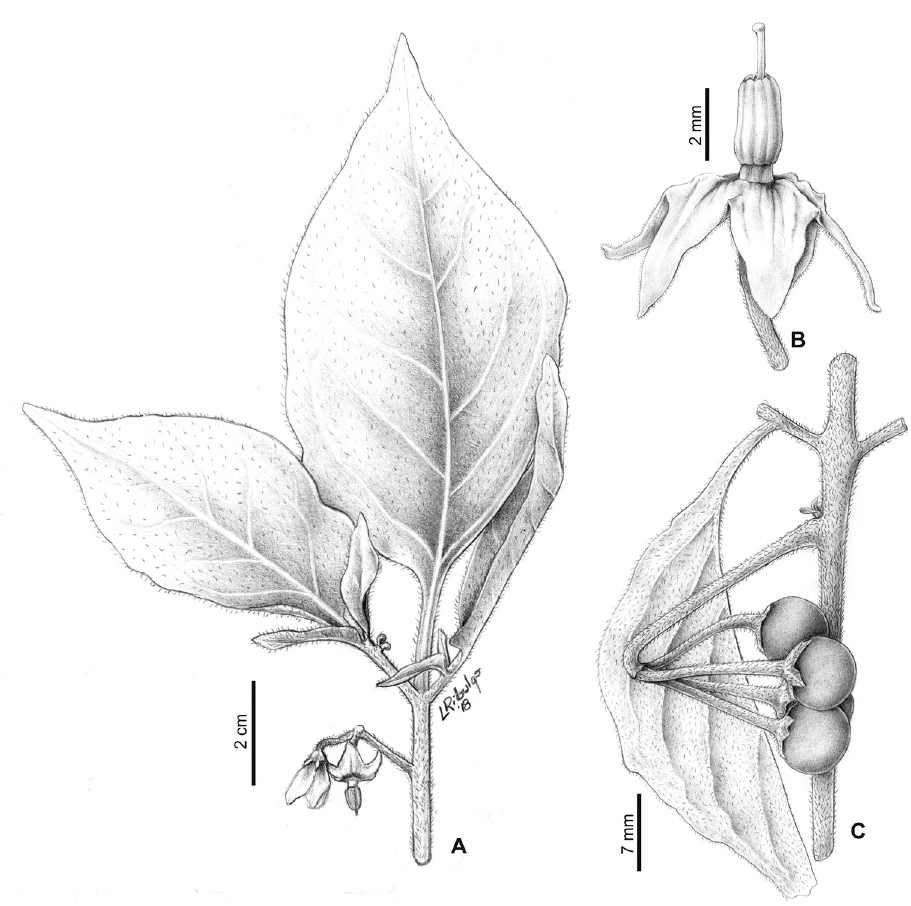
Figure 27. Solanum nigrescens M.Martens & Galeotti. A New shoot B flower C inflorescence with ma- ture fruit ( A–C Ventura A. 672 ). Drawing by L.